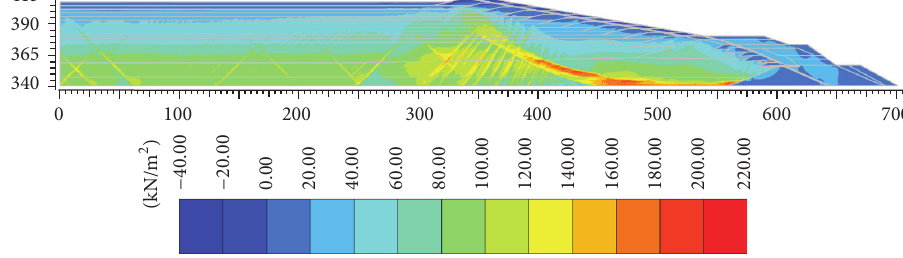
Figure 12: Excess pore pressures after the dam is shaken with normal earthquake. Negative sign indicates